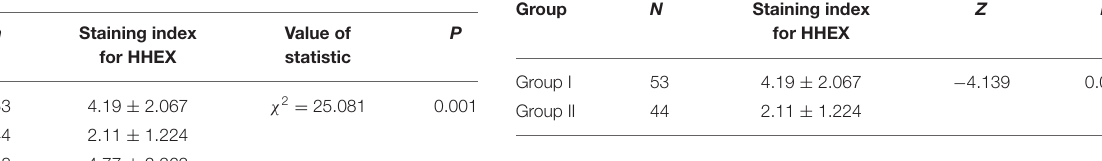
TABLE 2A | The differences of HHEX staining index among 53 cases of precancerous lesions (group I), 44 cases of primary BC (group II), and 48 cases of benign breast tumors (group III).